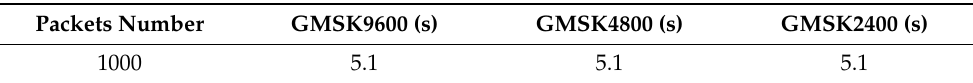
Table 4. The results for the test measuring the time to transmit 1000 packets of data at different data rates.